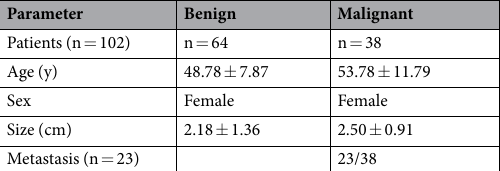
Table 1. This study was approved by our local Ethics Committee of the Chinese PLA General Hospital. Informed consent was obtained from all patients included in the study. The study was performed in accordance with rele- vant guidelines and regulations.